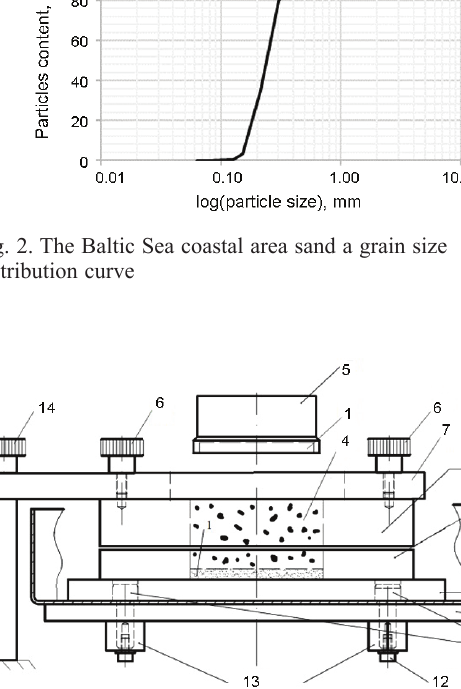
Fig. 3. Principal scheme for universal shear testing device ADS 1/3: 1 – porous stone; 2 – movable lower ring; 3 – fixed upper ring; 4 – soil; 5 – load piston; 6 – fixation of the upper ring; 7 – fixed support; 8 – water jacket; 9 – plate of the lower ring; 10 – movable plate of the base; 11 – fixators; 12 – fixation of the movable plate of the base; 13 – skids; 14 – support of the upper